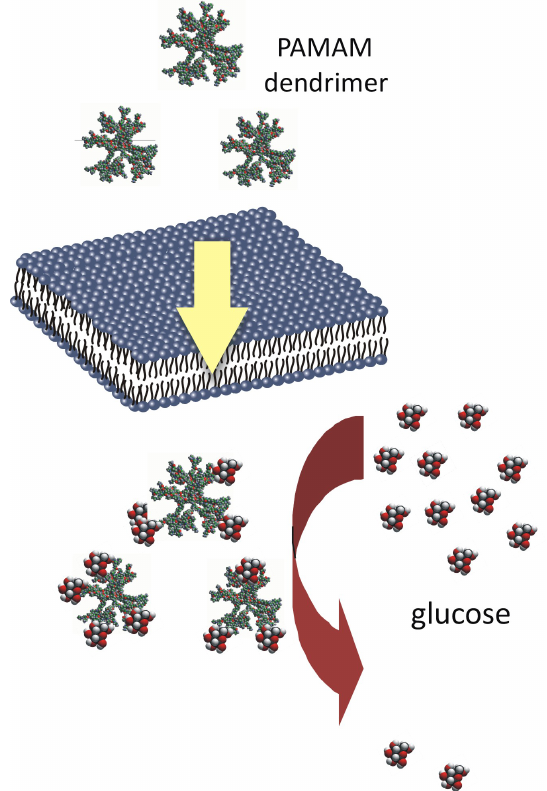
Figure 1. Schematic diagram depicting the basis for the use of full-generation PAMAM dendrimers as “scavengers” of excessive